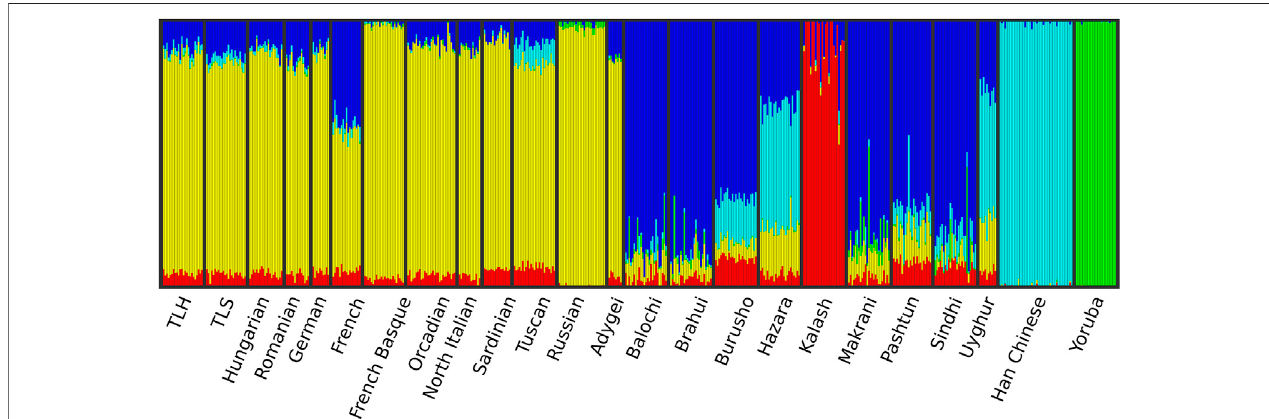
FIGURE 3 | Admixture analysis results of the investigated populations with K = 5 hypothetical ancestral groups.